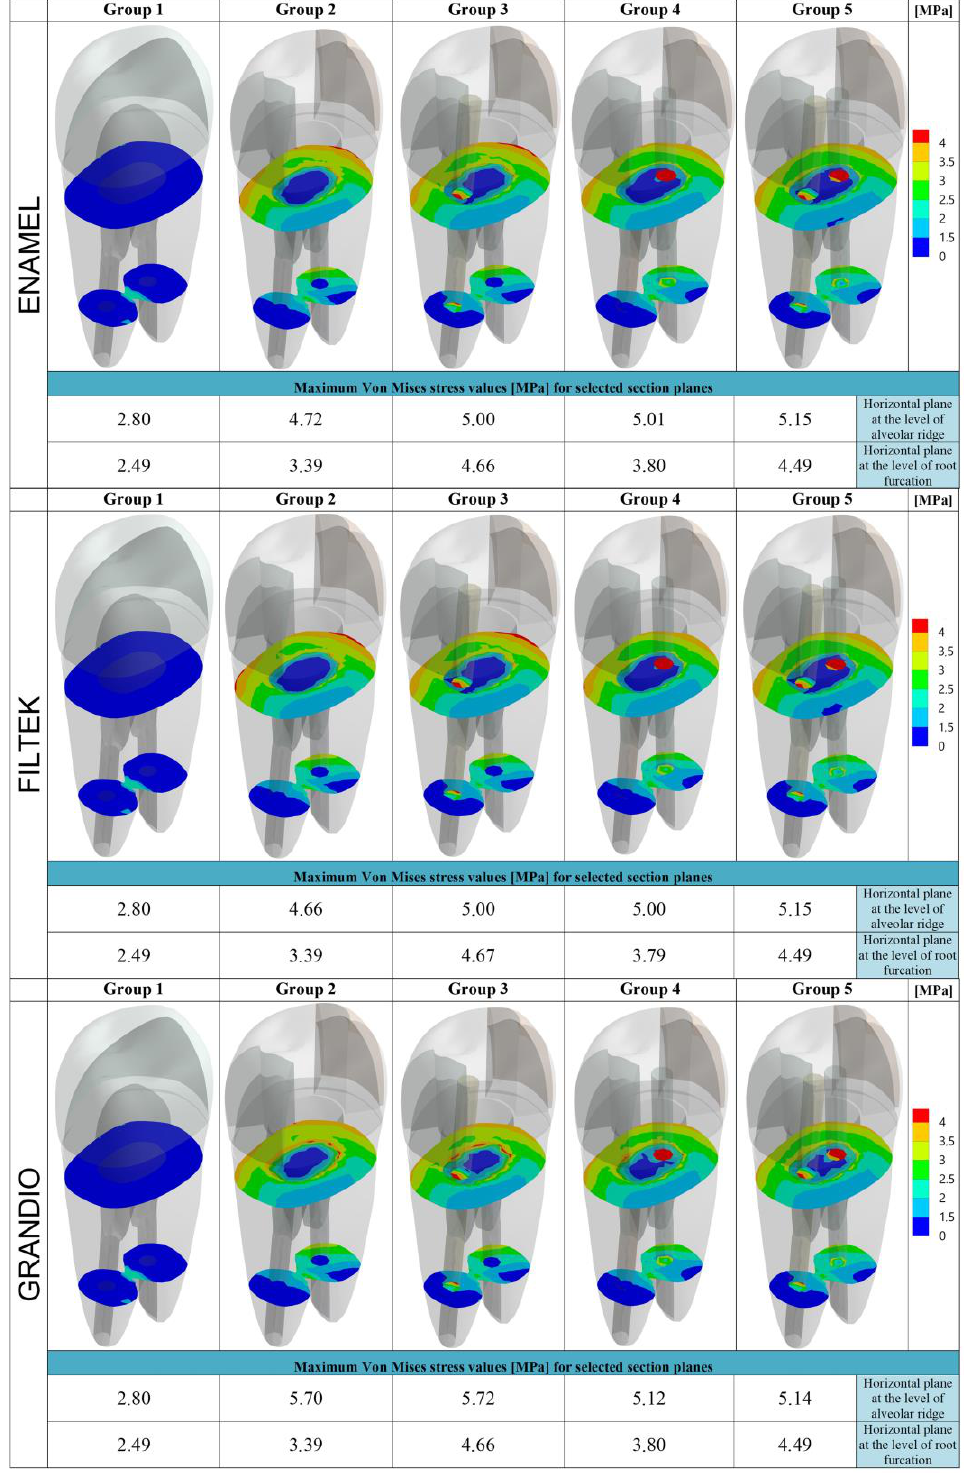
Figure 4. Von Mises maps and Maximum Von Mises stress values (MPa) recorded along the level of the alveolar ridge (cervical horizontal plane) and at the root-furcation level. The legend on the right side shows the colors (and the upper and lower limits) corresponding to the seven stress ranks used to analyze the stress distribution.